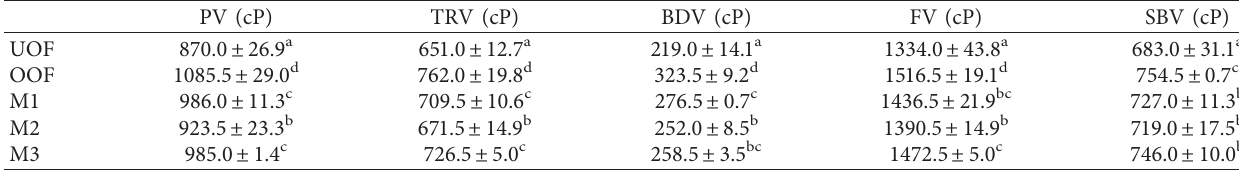
Table 2: The pasting parameters of wheat flour added with different ratios of overozonized wheat flour † .